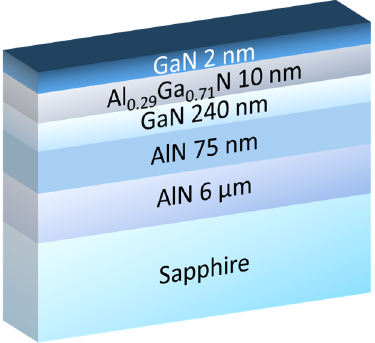
Figure 2. Schematic cross section of the thick channel structure.